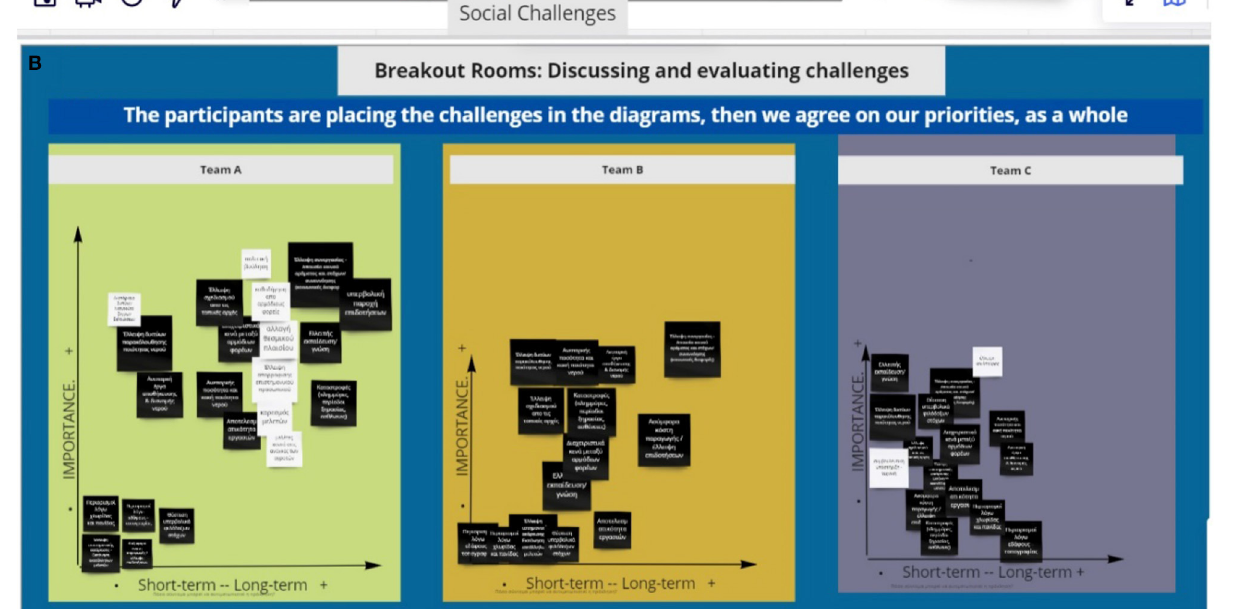
Frontiers in Water |